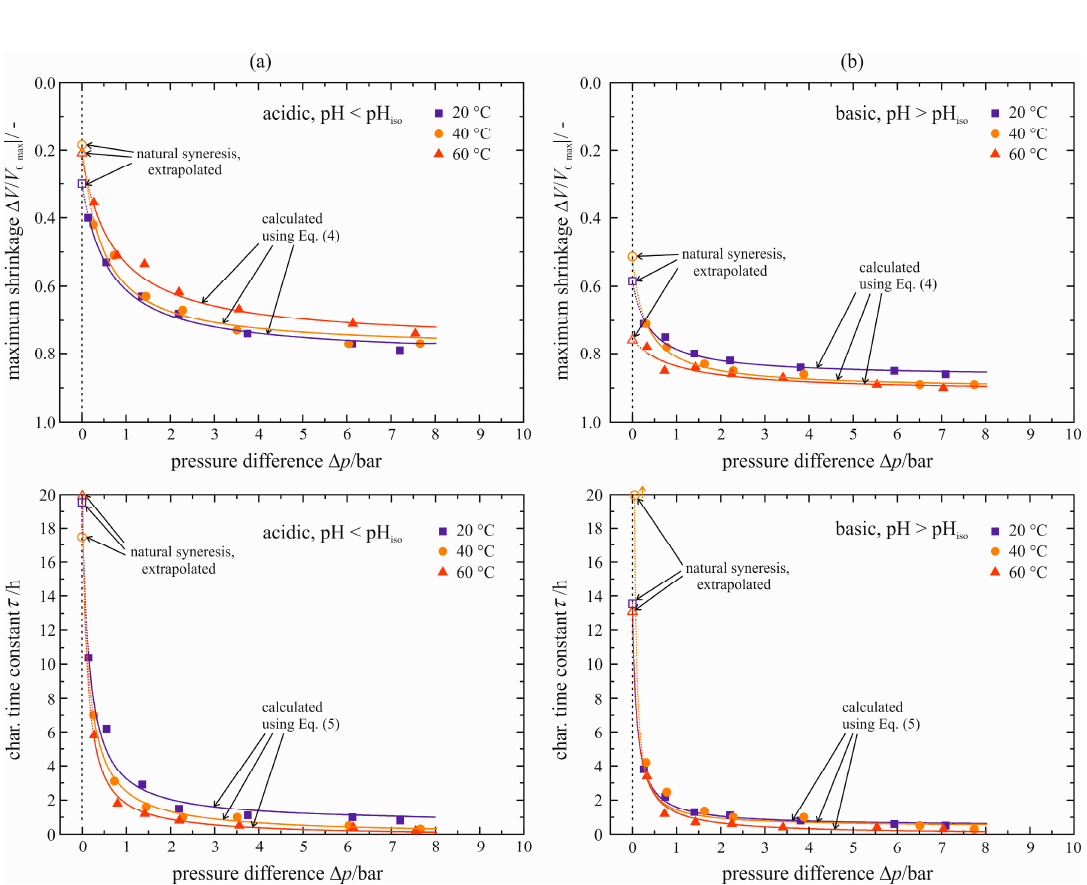
Figure 15. Maximum shrinkage Δ V / V 0 | max and characteristic time constant τ for acid-catalyzed ( a ) and base-catalyzed ( b ) gel as a function of pressure difference Δ p .